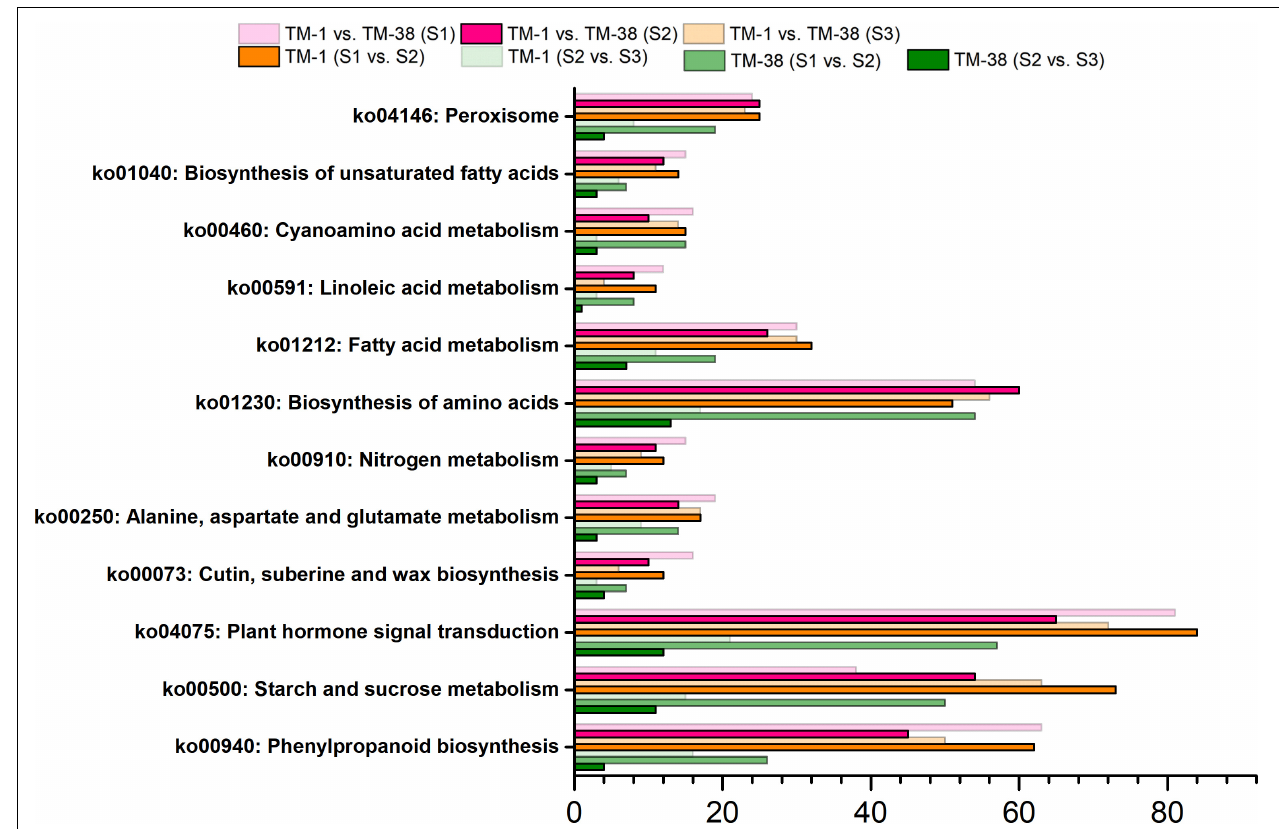
FIGURE 5 | Kyoto Encyclopedia of Genes and Genomes (KEGG) enrichment analysis of the annotated DEGs in TM-1 and TM-38 at three developmental stages.